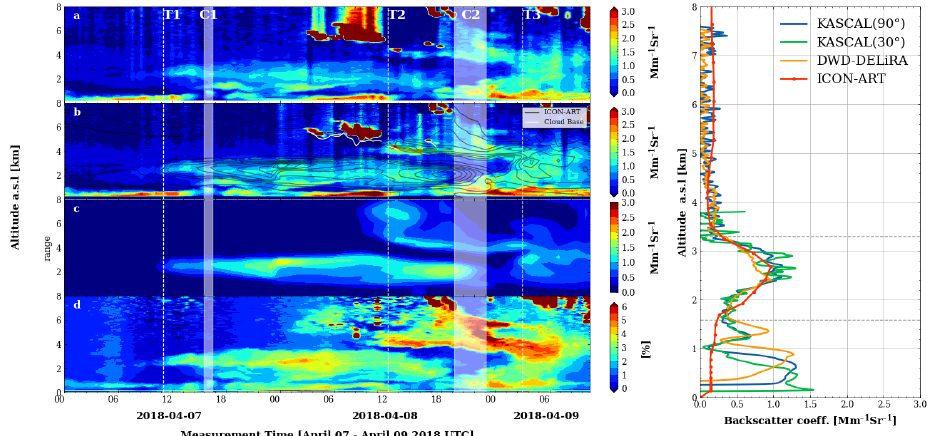
Figure 5. Time series of backscatter coefficients from KASCAL measurements ( a ) and from DWD- DELiRA measurements with ICON-ART results shown as black contour lines ( b ), as well as ICON- ART backscatter coefficients ( c ) and linear volume depolarisation ratios from KASCAL measurements ( d ) from 7 to 9 April 2018 . Please note that the model data shown only include the Saharan dust, while the LiDAR data show also other aerosol particles and clouds. The profiles of backscatter coefficients measured by the two LiDARs from 15:30 to 16:30 and predicted by ICON-ART for 16:00 on 7 April 2018 (indicated as C1 in the contour plots) are shown on the right side of this figure. The vertical dashed lines in the contour plots indicate dust arrival (T1), the appearance of the second dust layer (T2), and the two dust layers merging (T3). C1 and C2 represent the time periods used for a more detailed data